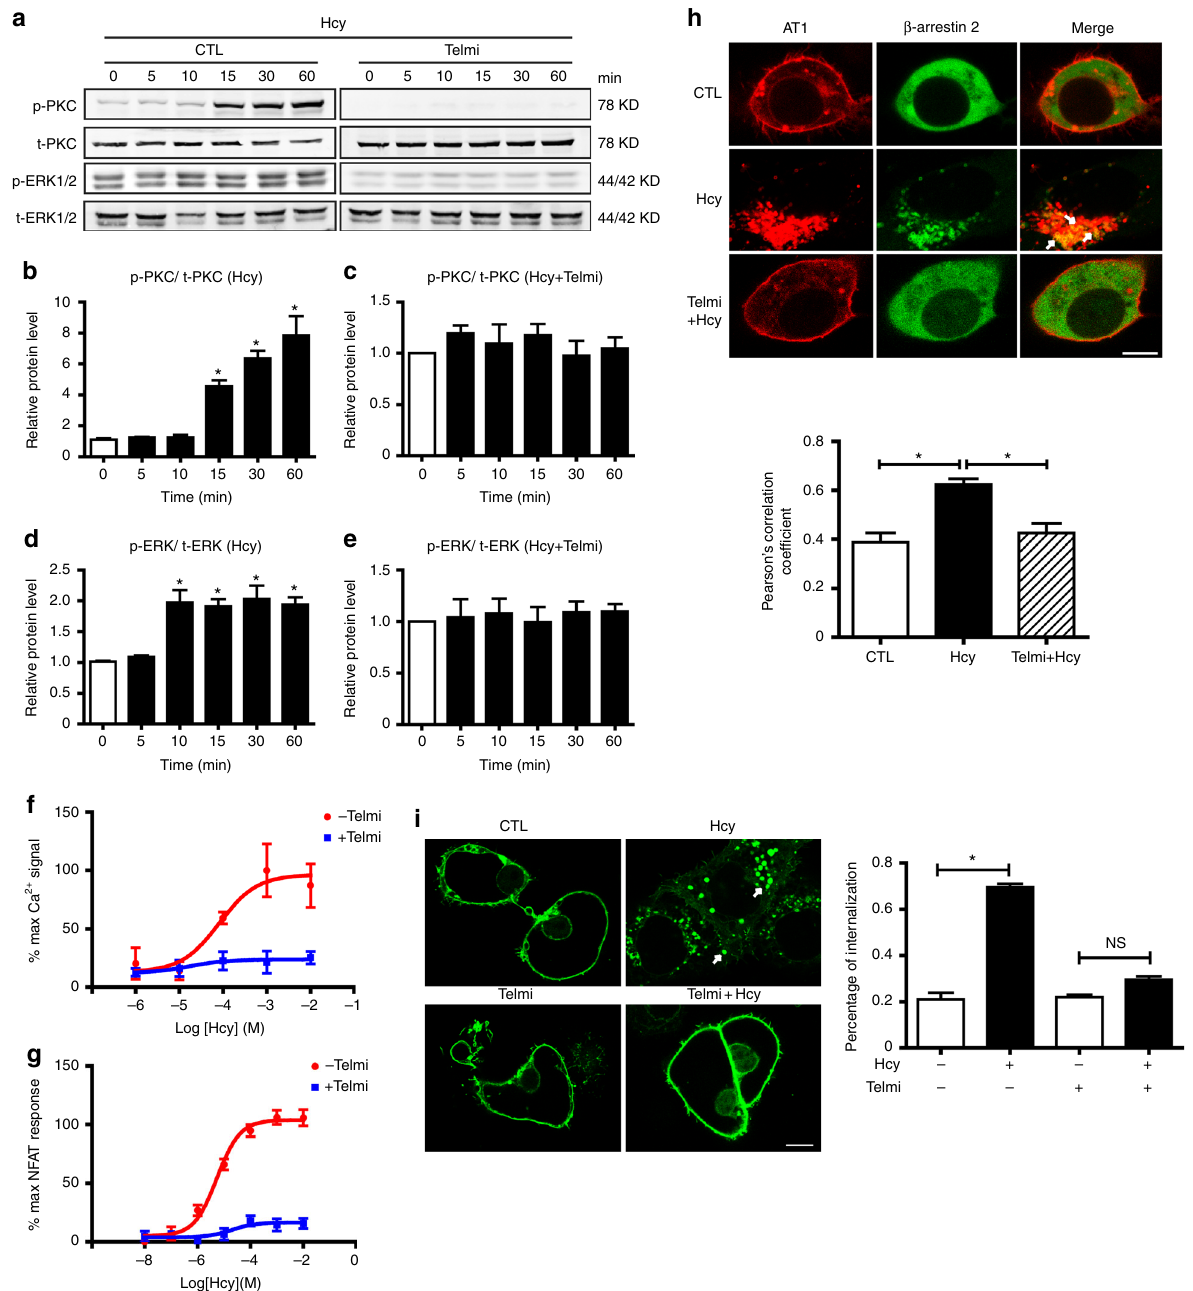
Fig. 2 Hcy activates the AT1 receptor downstream G q and β -arrestin 2 signaling pathways. a – e Representative western blots and quanti fi cation of phosphorylated and total PKC and ERK1/2 in Hcy (100 μ M)-treated HEK293A cells (transfected with the human AT1 receptor) with or without telmisartan (1 μ M) pretreatment. The data represent as mean ± SEM, N = 6. * P < 0.05, one-way ANOVA followed by the Bonferroni post hoc test. f Ca 2+ signaling in HEK293A cells (transfected with the human AT1 receptor) stimulated by Hcy with or without telmisartan (1 μ M) pretreatment, detected using Fluo 3-AM and quanti fi ed by the Leica confocal microscope system. The data represent as mean ± SEM, N = 6. g Hcy-induced NFAT signaling with or without telmisartan (1 μ M) pretreatment, detected by the dual-luciferase assay system (Promega). The data represent as mean ± SEM, N = 6. h Representative fl uorescence and quanti fi cation of Hcy (100 μ M)-induced co-localization of the AT1 receptor (overexpression of human AT1-mCherry plasmid; red) and β - arrestin 2 (overexpression of β -arrestin 2-GFP plasmid; green) in cultured HEK293A cells. The merged area is indicated as yellow (arrows). Scale bar, 10 μ m. The data represent as mean ± SEM, N = 6, * P < 0.05, one-way ANOVA followed by the Bonferroni post hoc test. i Representative fl uorescence and quanti fi cation of Hcy (100 μ M)-induced AT1 receptor (overexpression of mouse AT1a-GFP plasmid; green) internalization (arrows) with or without telmisartan pretreatment in COS7 cells. The data represent as mean ± SEM, N = 10, * P < 0.05, two-way ANOVA followed by the Bonferroni post hoc